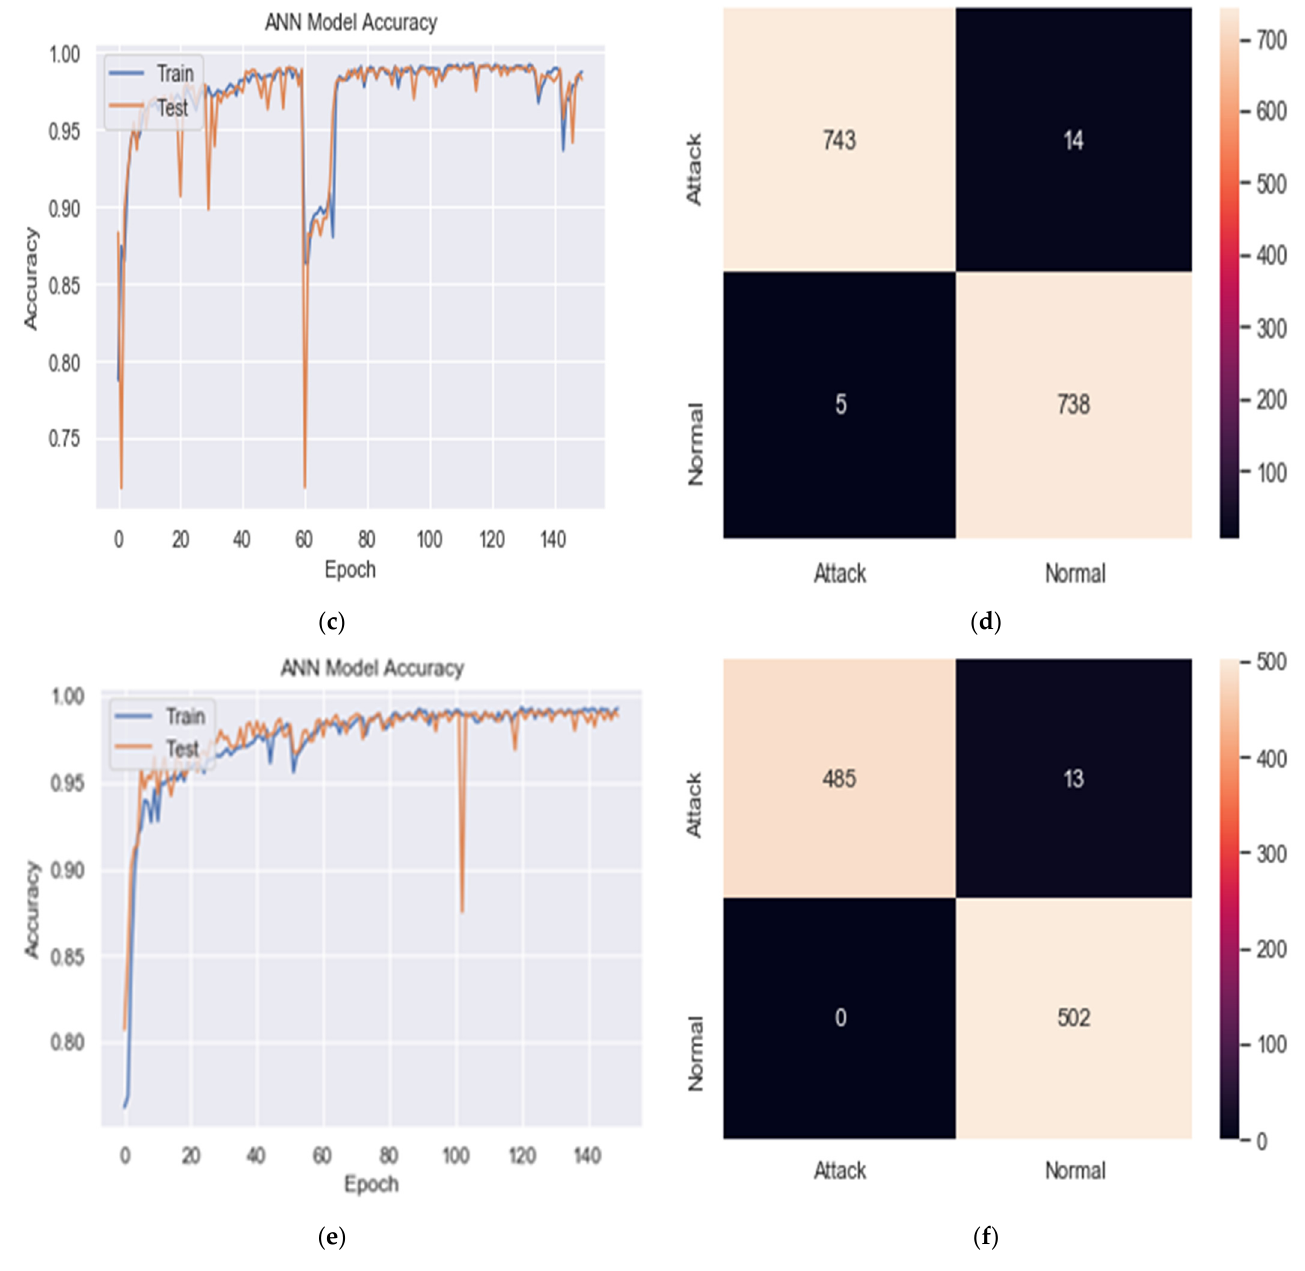
Figure 4. Training and validation accuracy and confusion matrix of DDoS detection results under the BDLSTM-autoencoder model. ( a ) Training and validation accuracy for (60, 20, 20) splitting, ( b ) confusion matrix for (60, 20, 20) splitting. ( c ) Training and validation accuracy for (70, 15, 15) splitting, ( d ) confusion matrix for (70, 15, 15) splitting. ( e ) Training and validation accuracy for (80, 10, 10) splitting, ( f ) confusion matrix for (80, 10, 10) splitting.